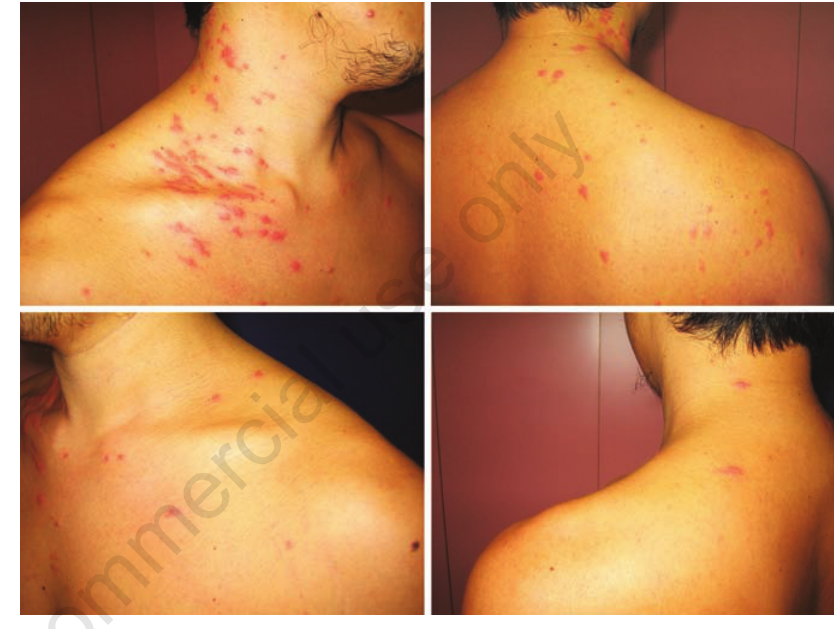
Figure 5. Erythematous papular lesions significantly more on the right neck and shoulder than on the left aspect of neck and left shoulder of a man with asymmetric periflexural